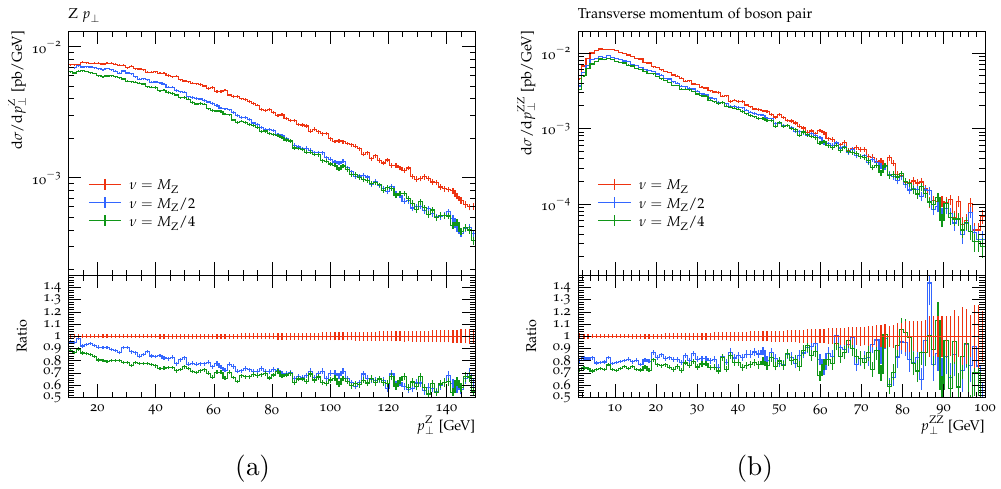
Figure 9 . (a) Transverse momenta of the Z 0 bosons and (b) transverse momentum of the Z 0 Z 0 pair as given by equation (3.22) with (cid:27) sub = 0 and for three di(cid:11)erent values of (cid:23) . The (cid:23) = M Z (Z ; Z) setup is the reference in the ratio plots. The histograms are not normalised to unity.